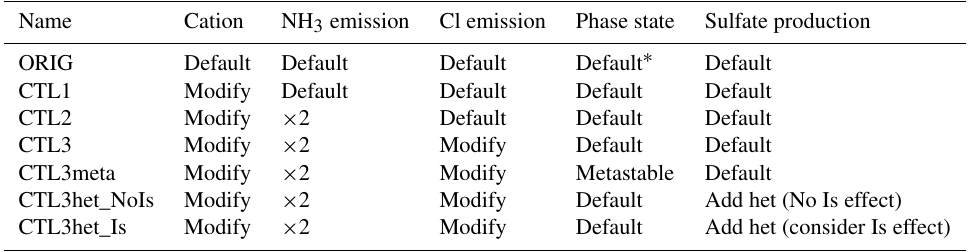
Table 2. Numerical experiments conducted in this study. Name Cation NH 3 emission Cl emission Phase state Sulfate production ORIG Default Default Default Default ∗ Default CTL1 Modify Default Default Default Default CTL2 Modify × 2 Default Default Default CTL3 Modify × 2 Modify Default Default CTL3meta Modify × 2 Modify Metastable Default CTL3het_NoIs Modify × 2 Modify Default Add het (No Is effect) CTL3het_Is Modify × 2 Modify Default Add het (consider Is effect)